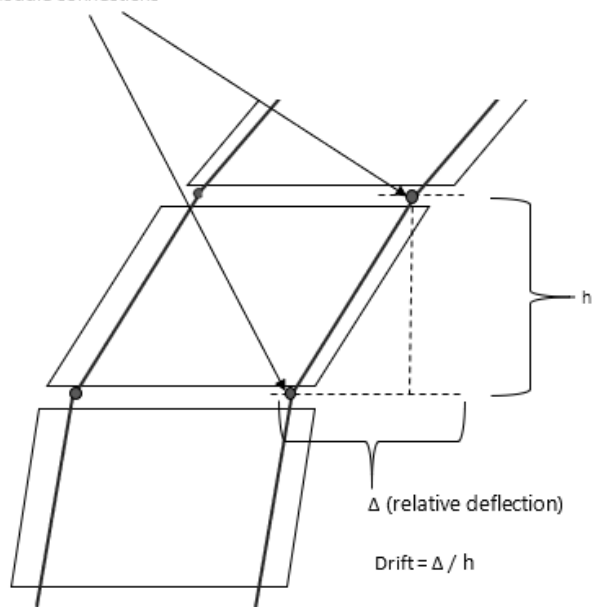
Figure 12. Illustration on how inter-storey drift needs to be considered for a corner-supported modular structural system against lateral loads.